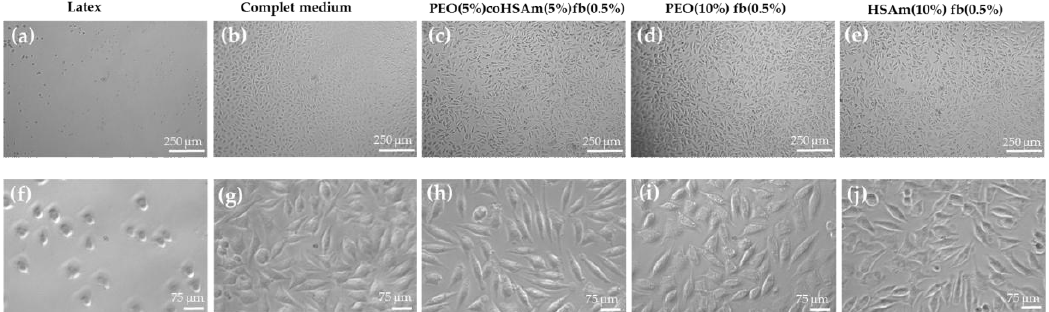
Figure 3. Morphology of cells exposed to IPN extracts. Phase contrast images of L929 cells three days